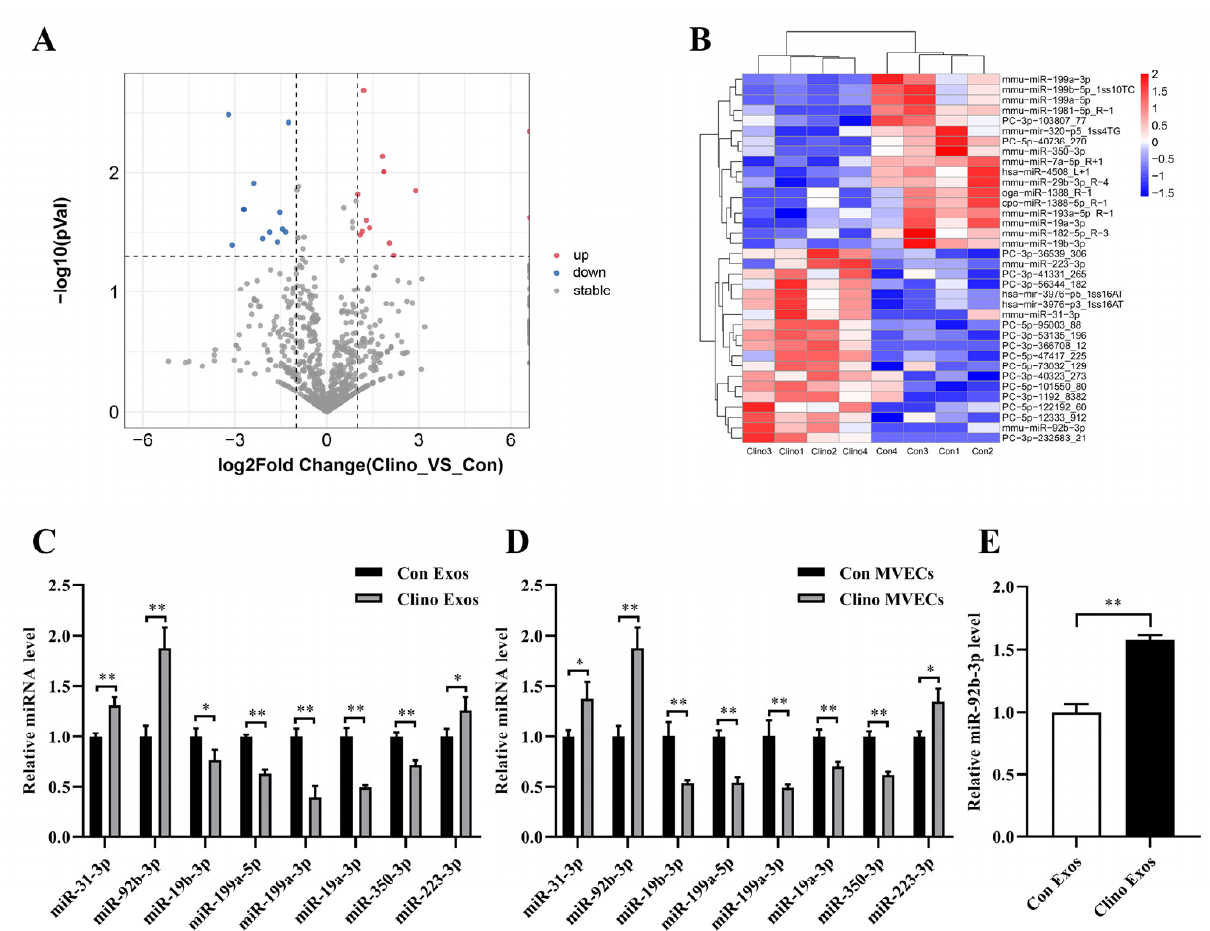
Figure 3. miR-92b-3p is elevated in MVEC-derived exosomes cultured under mechanical unload- ing. ( A ) Representative volcano plot of different levels of miRNAs between Con Exos and Clino Exos. ( B ) Representative heatmap of different levels of miRNAs between Con Exos and Clino Exos. ( C ) Differential miRNAs expression of Con Exos and Clino Exos was validated by qRT ‒ PCR ( n = 3). ( D ) qRT ‒ PCR was used to examine the differential expression of miRNAs chosen from RNA se- quencing data in MVECs subjected to mechanical unloading ( n = 3). ( E ) qRT ‒ PCR illustrated the level of miR-92b-3p in MC3T3-E1 cells incubated with Con Exos/Clino Exos (200 μ g/mL) ( n = 3). * p < 0.05, ** p < 0.01 vs. control.